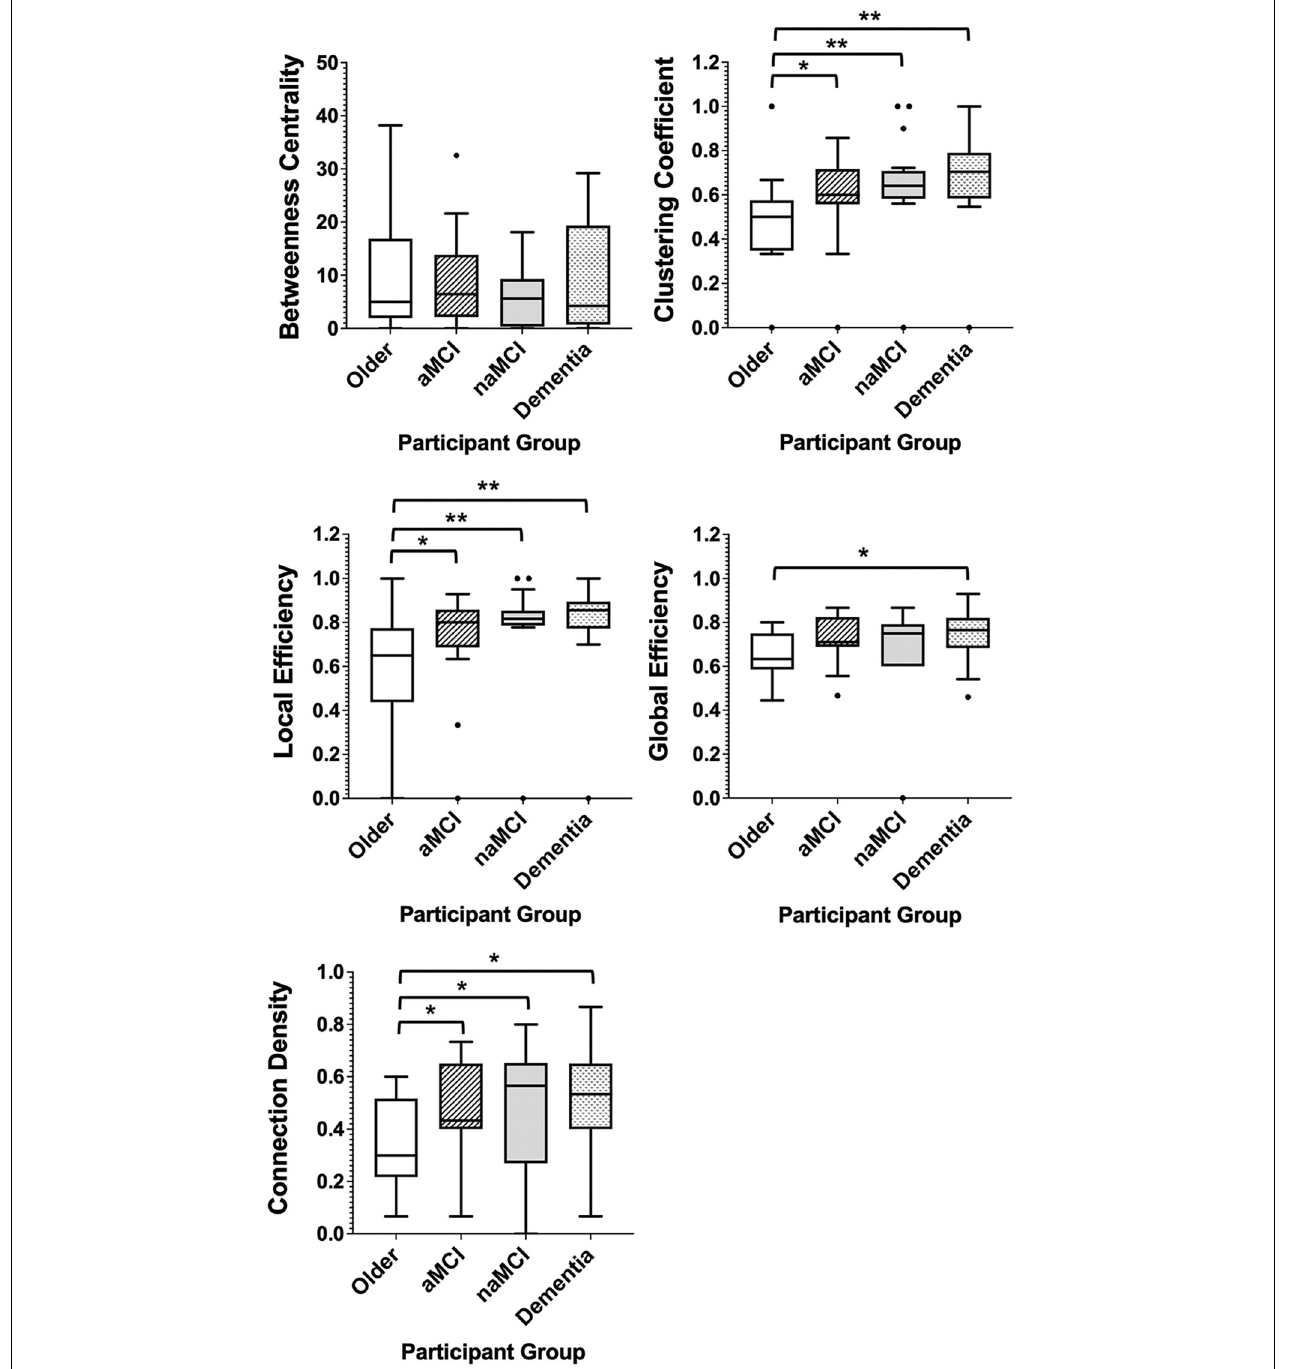
FIGURE 5 | Box plots showing the median and interquartile range of network metrics for the graphs of the older controls and patient groups. Significant differences calculated using independent two-tailed Mann–Whitney U tests. * p < 0.05, ** p <